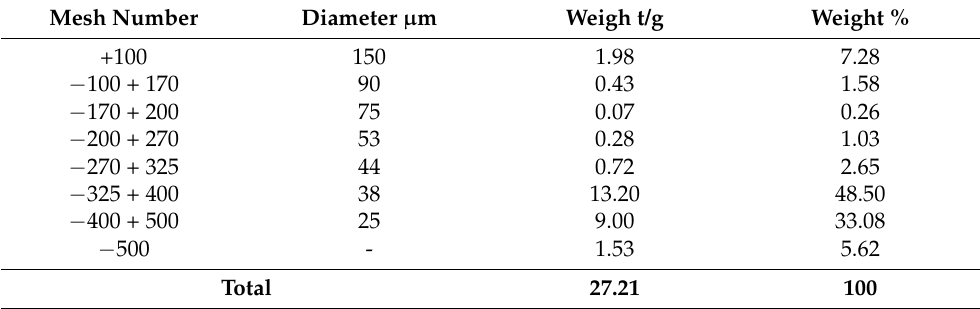
Table 4. Particle size distribution conducted by wet sieving of the synthesized product (weight